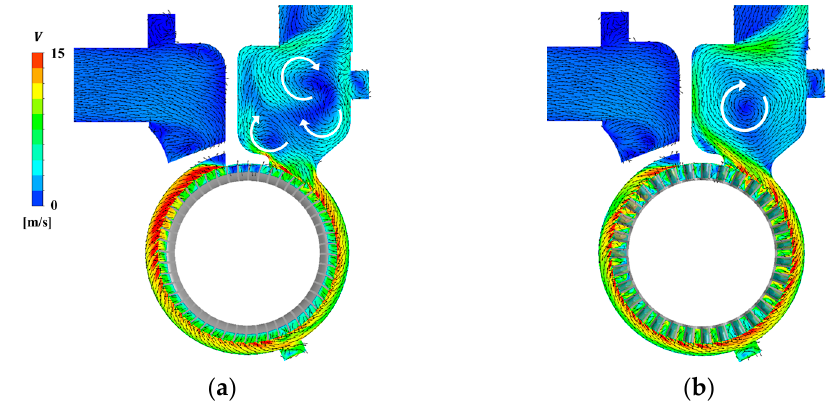
Figure 16. Velocity contours and vectors on Plane 2: ( a ) reference pump; ( b ) optimized pump.